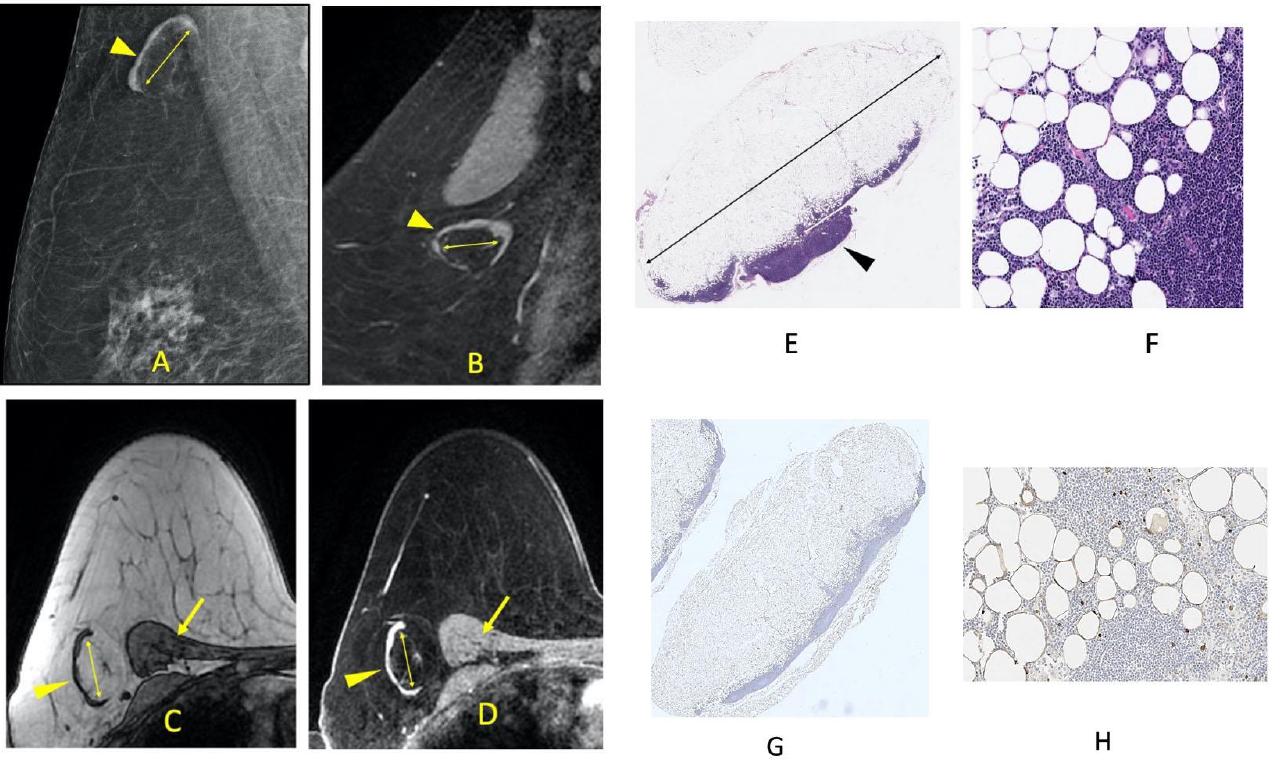
Figure 1. A non-metastatic fat-infiltrated axillary lymph node measuring 34 mm in a 67-year-old female with node-positive right breast cancer. Enlarged fatty hilum (double arrows) and thin peripheral cortex (arrowheads) are visualized on a right breast medio-lateral oblique mammogram ( A ), and on a sagittal contrast-enhanced right breast MRI ( B ). Axial breast MRI confirms that the expanded fatty hilum within the fat-infiltrated lymph node (double arrows) is composed of fat that is hyper-intense on the pre-fat-saturated sequence ( C ) and hypo-intense on the fat-saturated sequence ( D ). The fat signal within the lymph node hilum on the pre- and post-fat-saturated sequences is similar to the fat within the breast and axilla and is different from the peripheral thin lymph node cortex (arrowhead) and adjacent chest wall muscles (thin arrows). The histology of a non-metastatic sentinel node obtained at the time of breast cancer surgery confirms the extensive fatty expansion of the lymph node hilum (double arrow) with a slender rim of lymph node tissue retained at the periphery (arrowhead) (H&E, 1× magnification) ( E ). Sheets of adipocytes are seen infiltrating into and replacing the lymphocytes at a higher magnification ( F ) (H&E, 20 × magnification). Low power microscopic image showing adipocytes replacing hilar and parenchymal lymph node tissue. The adipocytes are highlighted with a brown S100 immunostain ( G ) (S100, 1 × magnification). Adipocytes, highlighted by expression of brown S100, seen infiltrating and replacing lymph node tissue. The background lymphocytes are S100 negative ( H ) (S100, 20 ×